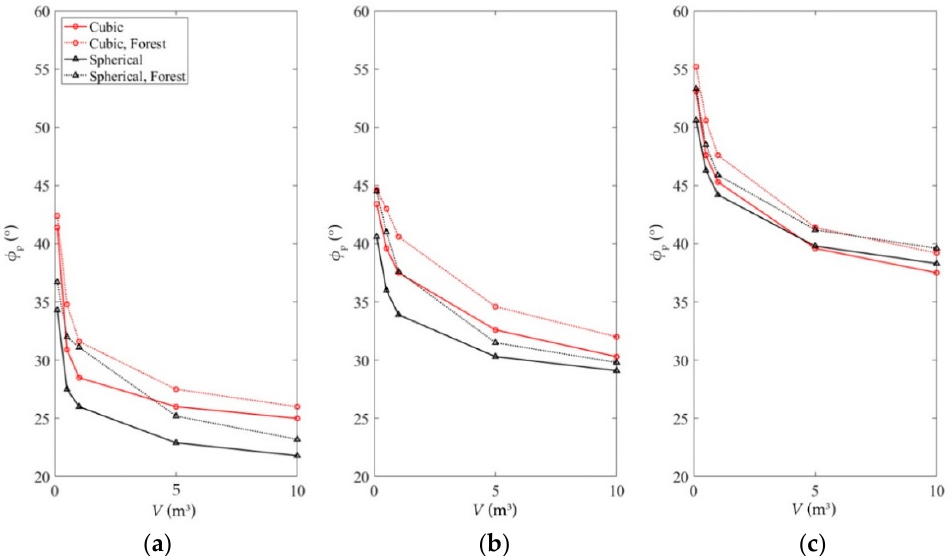
Figure 9. Results of the parametrical simulations for ( a ) ω 2 = 30 ◦ , ( b ) 45 ◦ and ( c ) 60 ◦ slopes. Energy angle values are given as a function of block volumes and forest coverage.